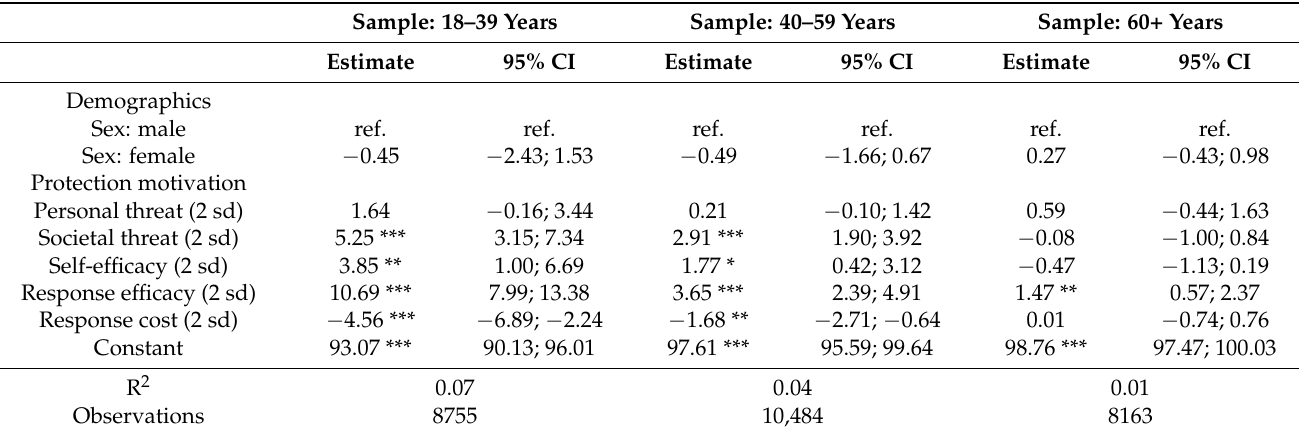
Table 4. Booster vaccine willingness estimates by